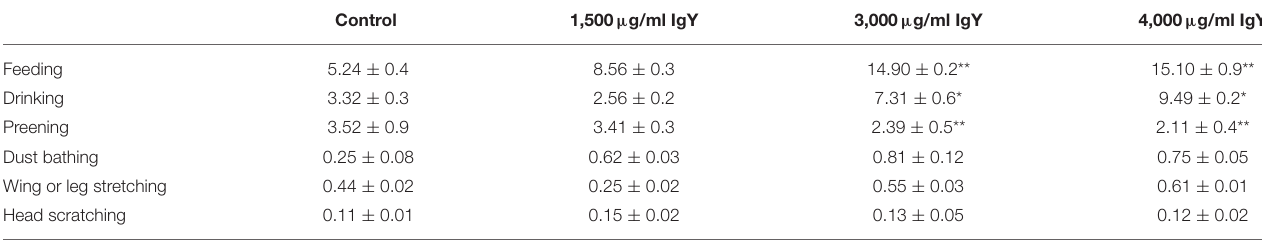
TABLE 2 | Behavioral observations (mean ± SEM) recorded in various experimental groups.